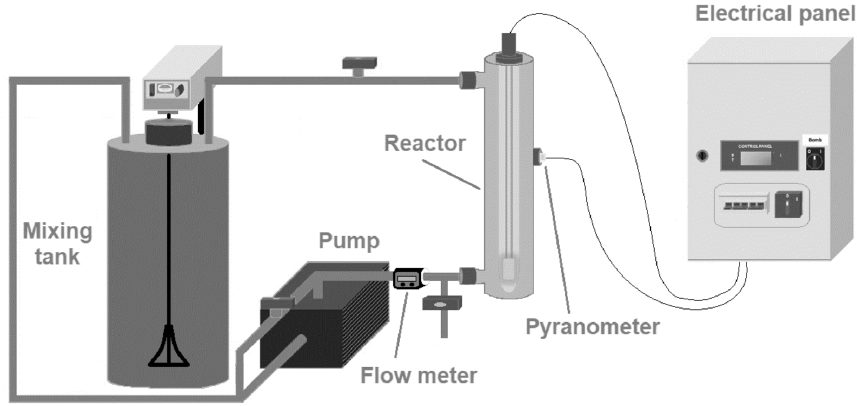
Figure 1. Schematic of the experimental equipment used to carry out the photocatalytic tests with aniline and benzothiazole.